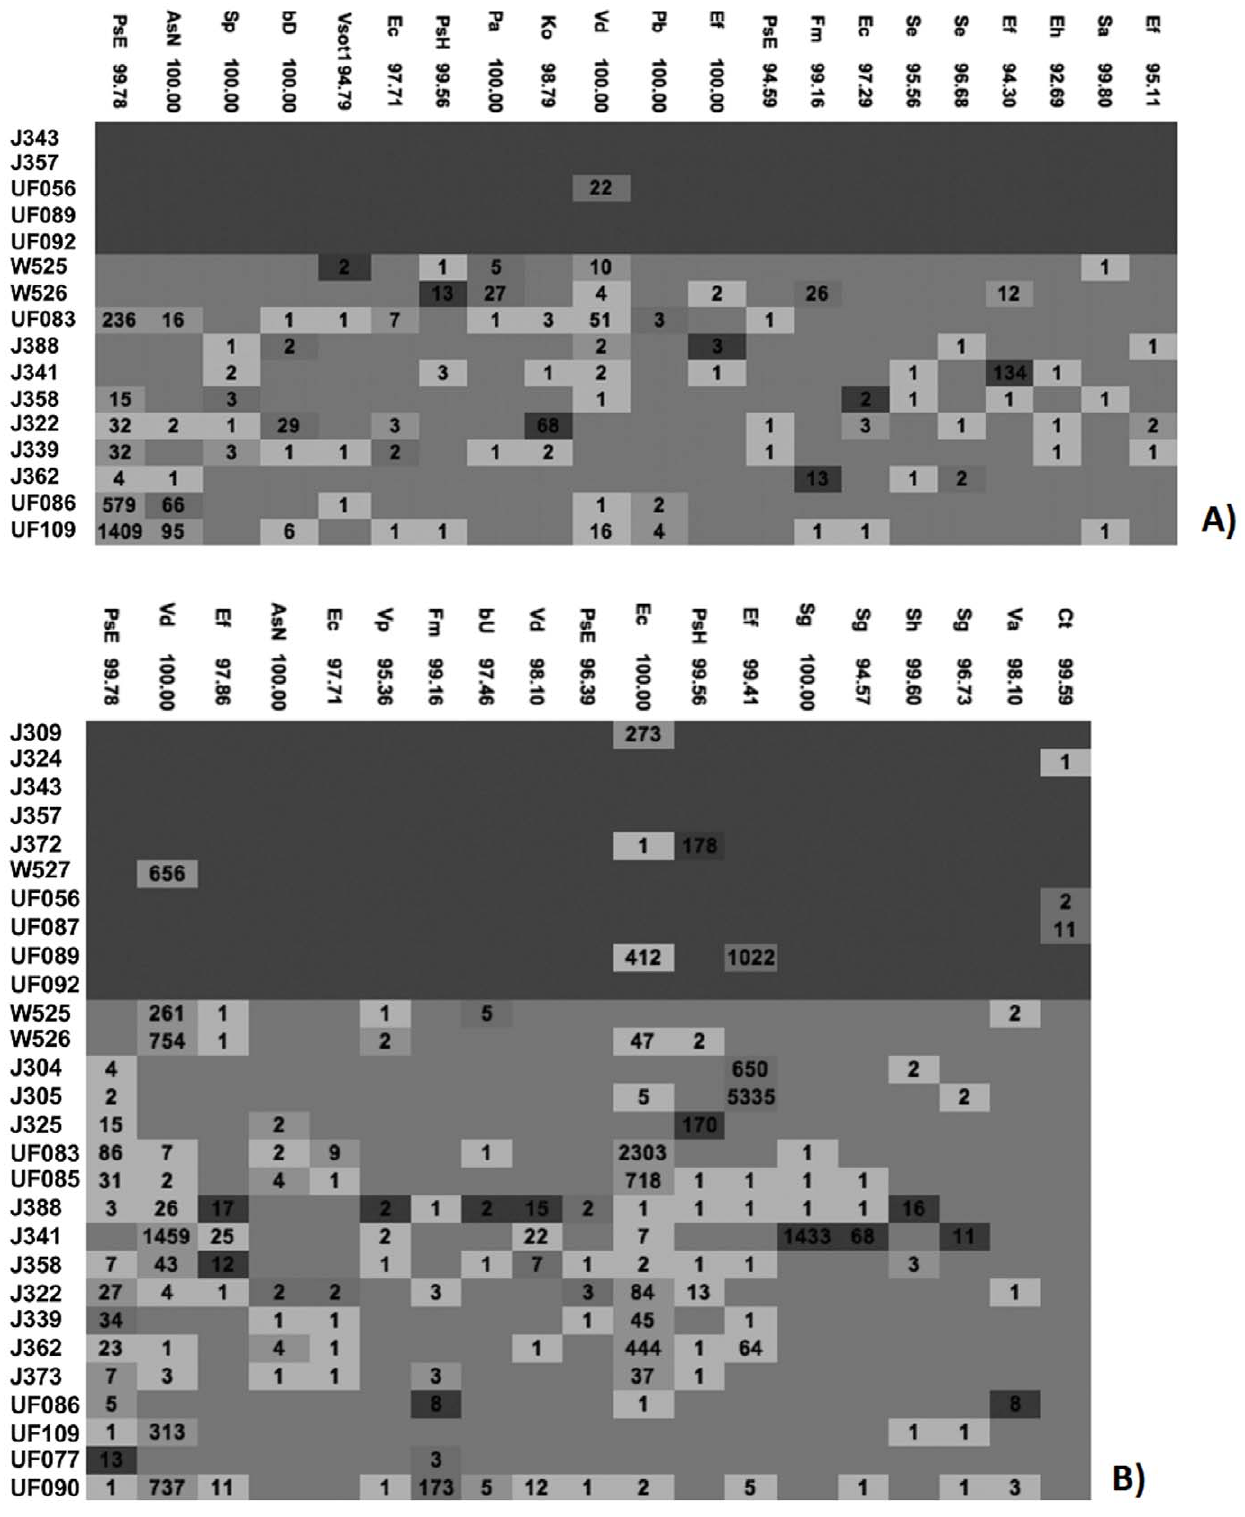
Figure 5. Differences in OTU abundance. Heat map of selected OTUs at 98% similarity by subject A) 2 weeks before and B) within 72 hours of LOS diagnosis. Sepsis cases are shown on the top (dark blue shaded area) and controls in the bottom (light blue shaded area). Cell Colors indicate the ratio for a particular OTU in a sample to the average ratio of this OTU in all samples. Dark red: . 10, light red: . 5 and , =10, light green: . 1.5 and , =5 and light blue: , =1.5. Numbers indicate how often the OTU was detected. List of full names for closest matches shown by abbreviation in Figure 5 are listed below: AsN Achromobacter_sp._N2 Bb Bifidobacterium_breve Cp Clostridium_perfringens Cs Cronobacter_sakazakii CsC Clostridium_sp._CS4 Ct Corynebacterium_tuberculostearicum Ea Enterococcus_avium Ec Escherichia_coli Ec Enterobacter_cloacae Ef Enterococ-